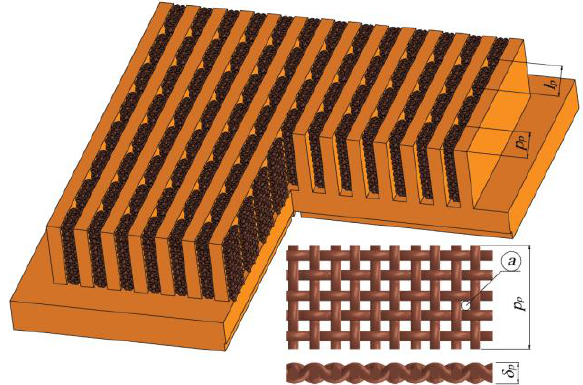
Fig. 5. 3D model of specimen MCC-M-3.5-0.5-2. Specimens having a porous structure inside the minichannels are marked with M or F (mesh or foam). For specimens with porous material pieces in the minichannels, the code consists of three variables from Table 1: pitch, thickness of a single layer, number of meshes placed side by side in the